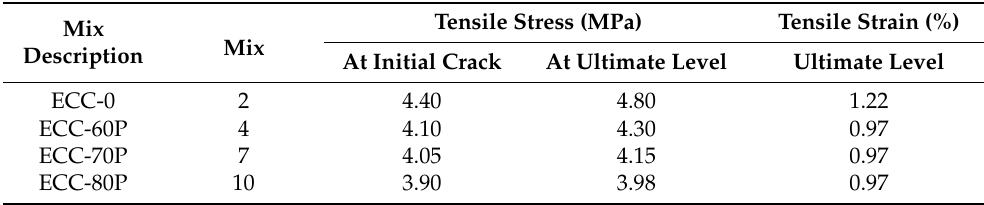
Table 6. Direct tensile test results.